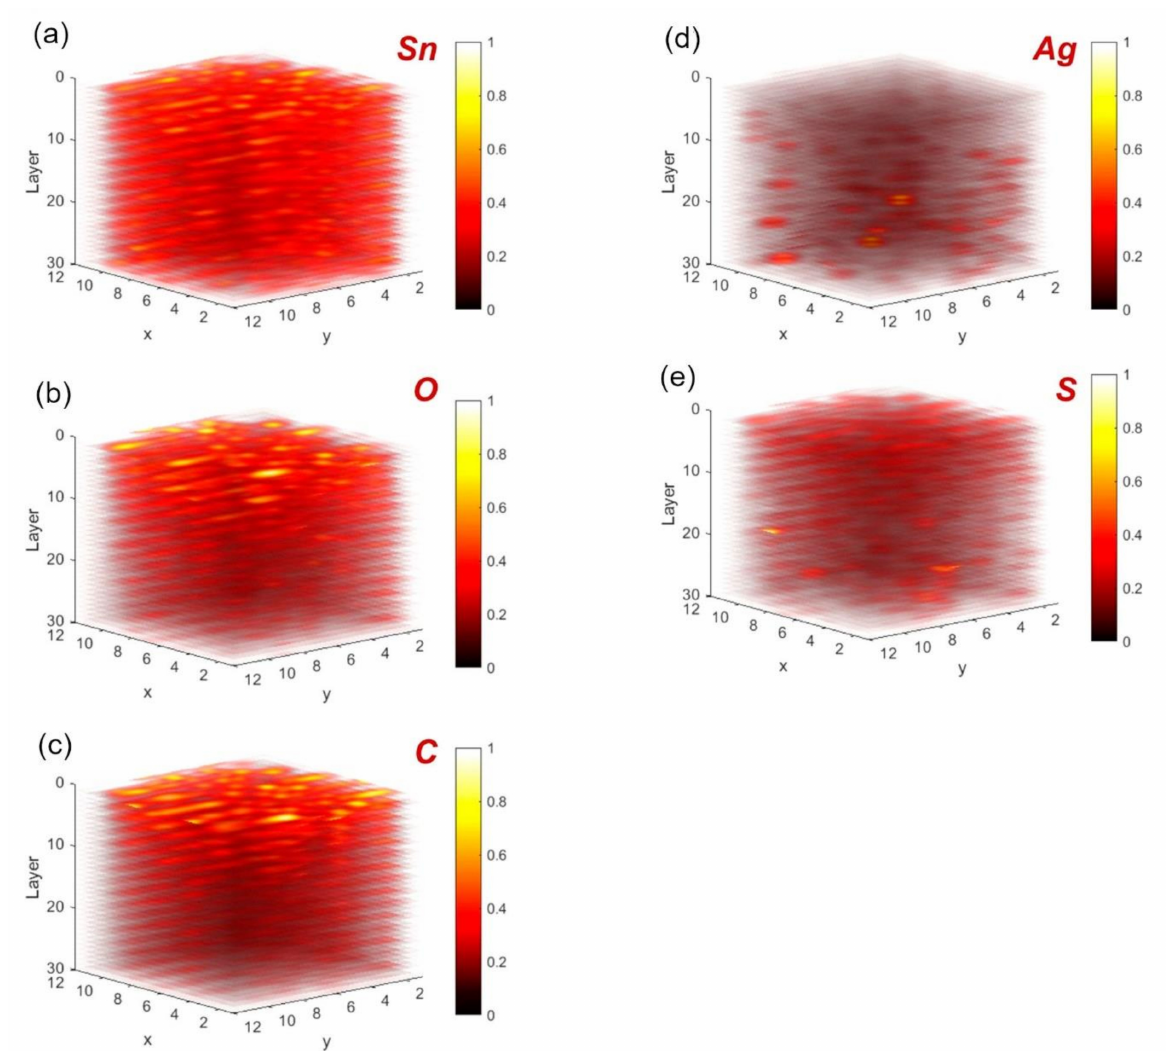
Figure 14. Signal intensity distribution of Sn, Ag, and the most relevant organic contaminants C, O, and S within the surface and early bulk region of the SnAg solder bump analysed by the 2D layer binning approach. Top row: depth profiles, bottom panels: 3D chemical imaging prepared on several elements. Differences in the alloy homogeneity, SnAg, and the spatial distribution of individual organic plating bath constituents (C, O, S) are apparent. Data have been normalized to the maximum signal intensity for this representation. Reprinted with permission from